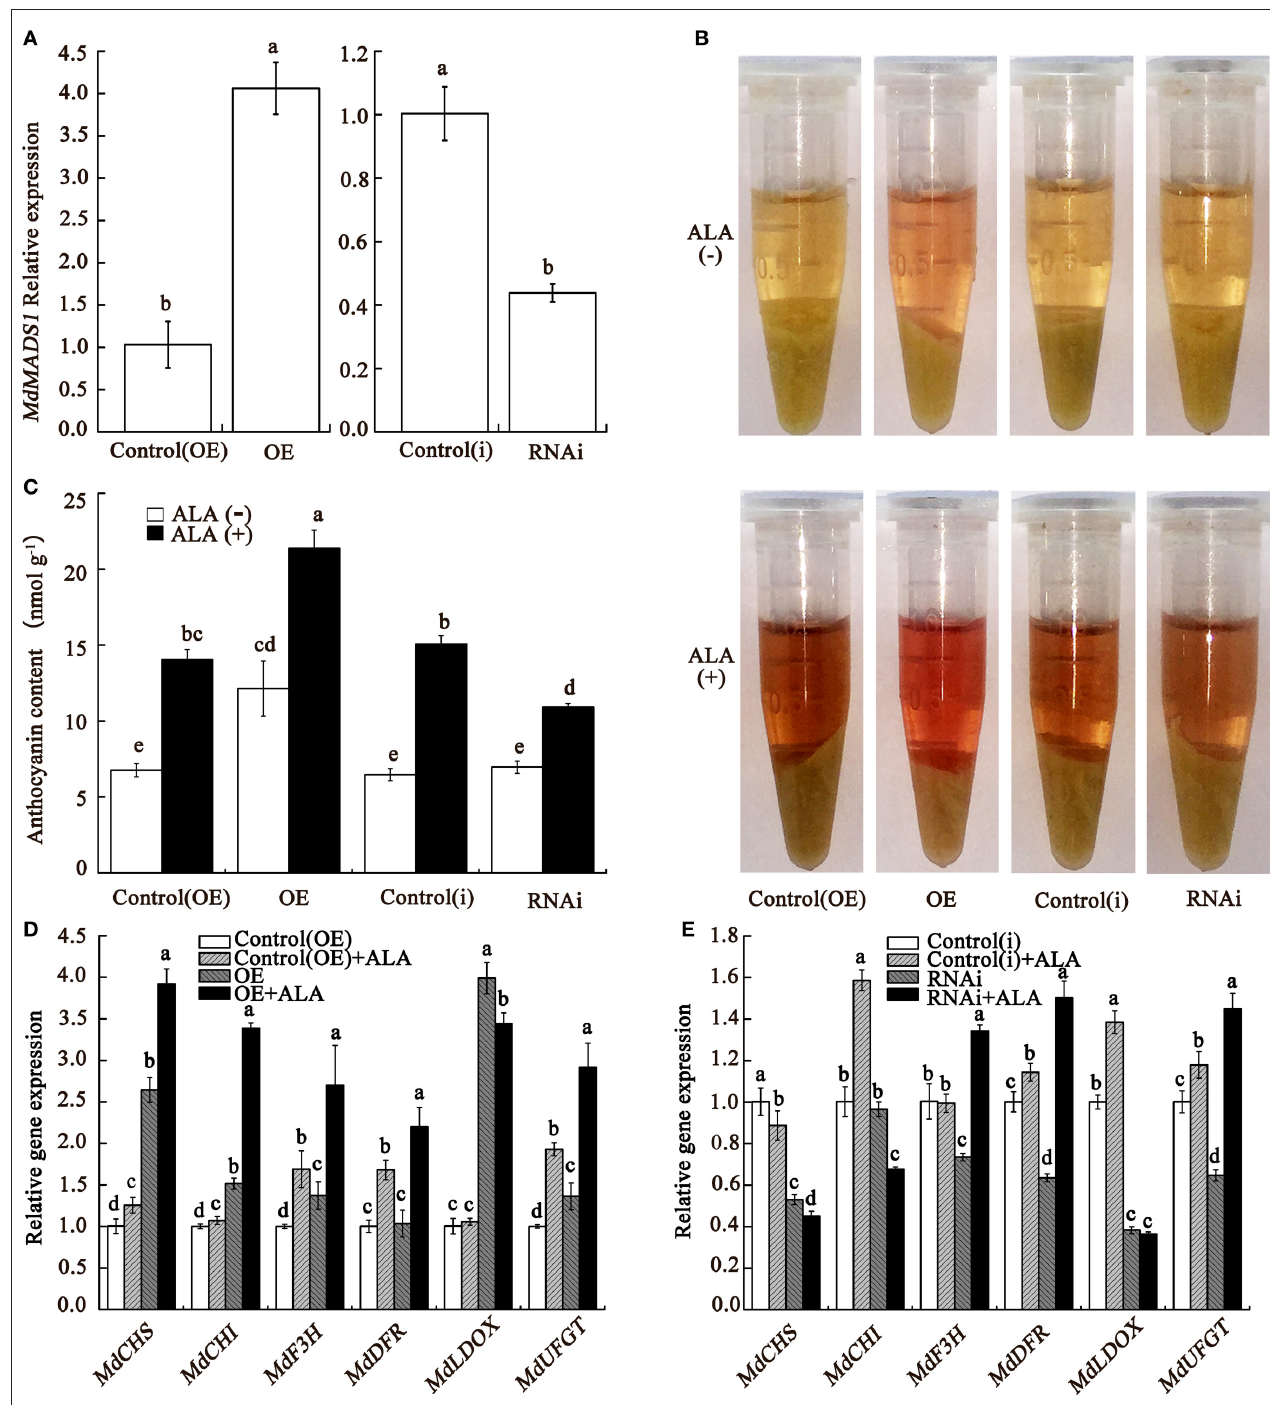
FIGURE 6 | MdMADS1 involves in ALA-induced anthocyanin accumulation. The calli were induced from Fuji fruit on MS medium containing 1 mg/L BAP and 1 mg/L 2, 4-D at 25 ◦ C in the dark. (A) qRT-PCR analysis of the relative expression of MdMADS1 in transgenic calli. (B,C) Color (B) and anthocyanin content (C) in transgenic calli. (D,E) ALA regulated the expression of anthocyanin biosynthetic genes in overexpression (D) and RNAi (E) transgenic calli. The expression level of each gene in the control(OE) or the control(i) calli was used as a reference sample. The expression level of each gene in calli was used as a reference sample. OE, calli infiltrated with the plasmid for overexpressing MdMADS1 ; Control(OE), calli infiltrated with an empty pBI121 vector; RNAi, calli infiltrated with the plasmid for silencing MdMADS1 ; Control(i), calli infiltrated with an empty pHELLSGATE2 vector.